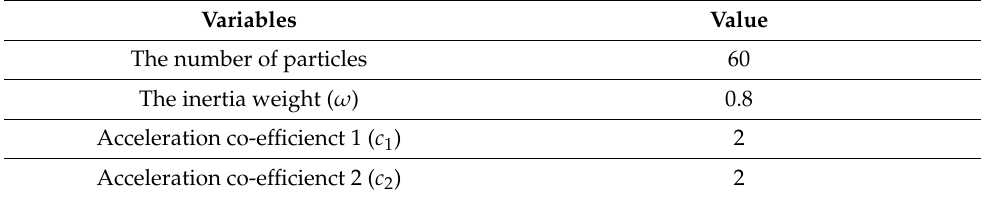
Table 1. Essential PSO variables for the numerical